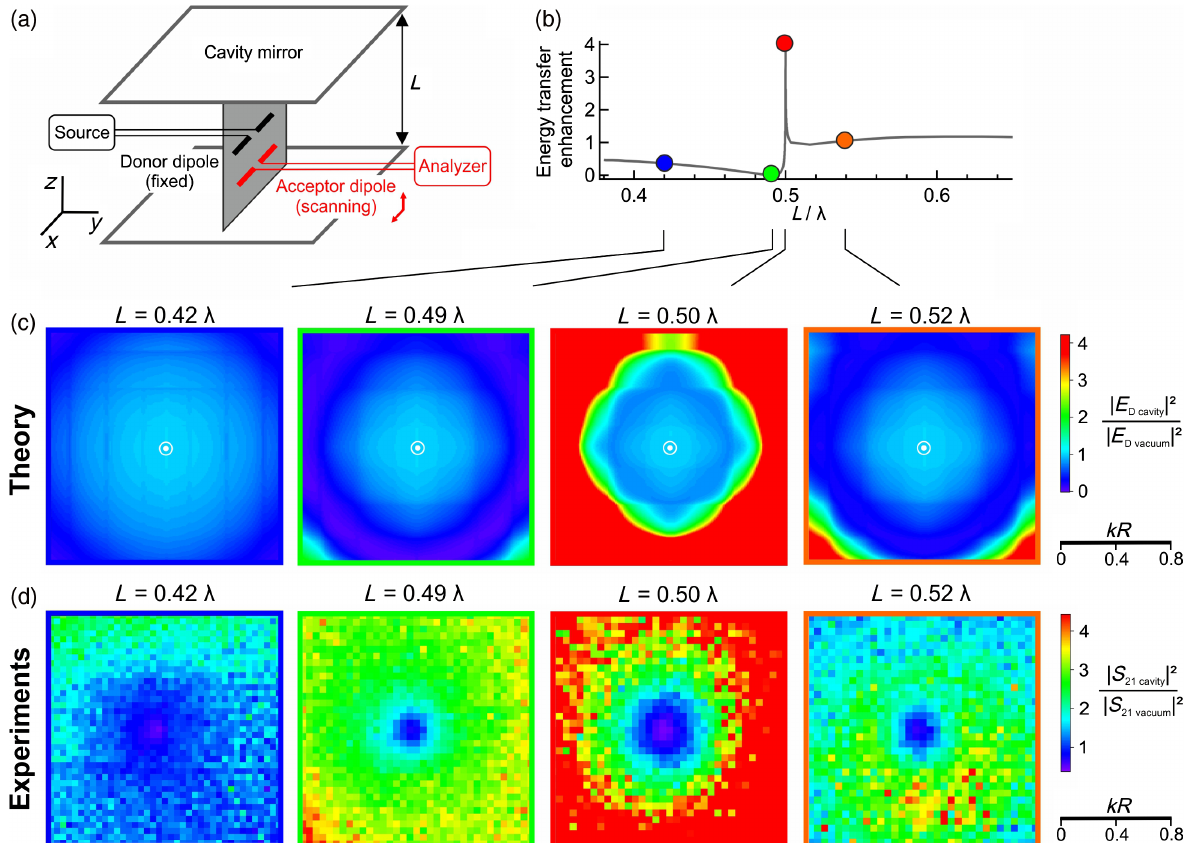
FIG. 3. Spatial maps of the energy-transfer enhancement inside the cavity. (a) Sketch of the experiment. The donor dipole (black) is fixed at 11.2 cm from the nearest mirror, while the acceptor dipole (red) is scanned to record the energy transfer at a fixed frequency. All data are then normalized to the same experiment performed without the cavity. (b) Simulation of the energy-transfer enhancement versus cavity lengths, with the lengths used in the experiments indicated by colored dots. For this simulation, a dipole-dipole distance of 7.6 cm (corresponding to kR ¼ 0 . 8 ) was used. (c) Simulated maps of the energy-transfer enhancement inside the cavity for two dipoles oriented along X and for different cavity lengths below, at, and above resonance. The white dot indicates the donor dipole position. Maps computed for a larger spatial domain up to kR ¼ 2 are shown in the Supplemental Material, Fig. S2 [66]. (d) Measured maps of the energy-transfer enhancement for cavity lengths below, at, and above the resonance condition. The central dip (purple spot) corresponds to the donor dipole